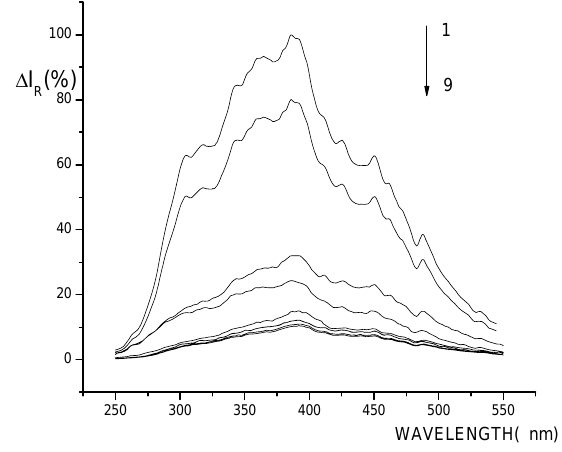
Figure 1. Apparent RLS profiles of Eu 3+ -nicotinic acid with DNA and